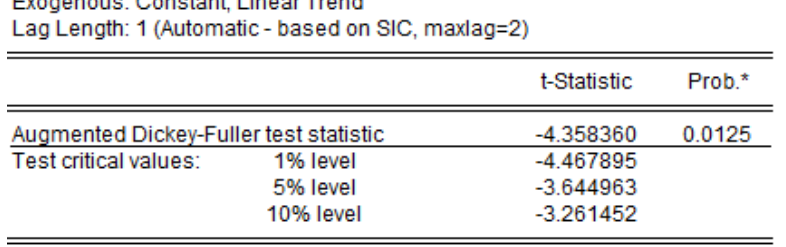
Figure 2. Results of the Dickey-Fuller test for the indicator “number of infected persons with the Covid- 19 coronavirus infection”